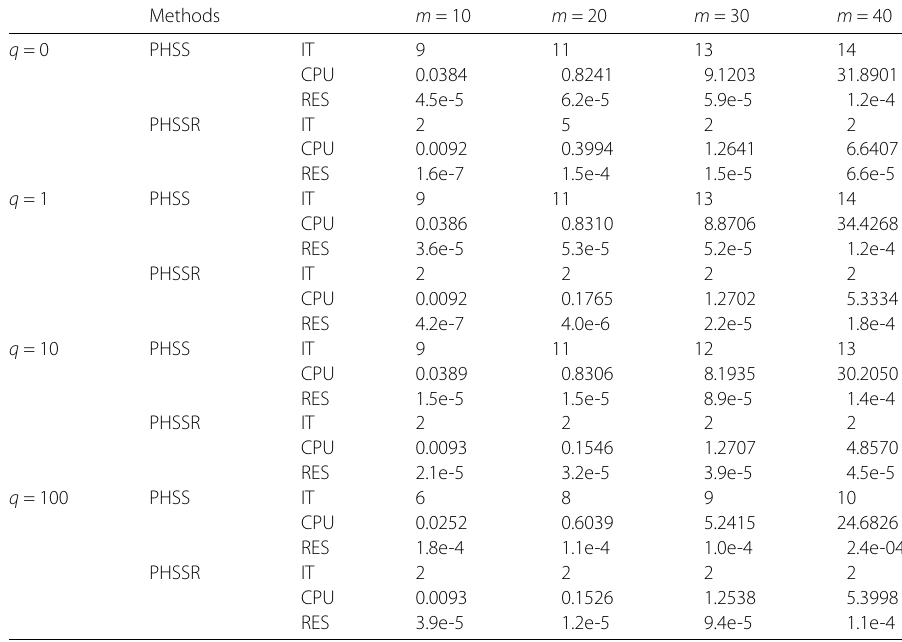
Table 2 Numerical results for the test problem with different values of m and q ( p = 0.5) Methods m = 10 m = 20 m = 30 m = 40 q =